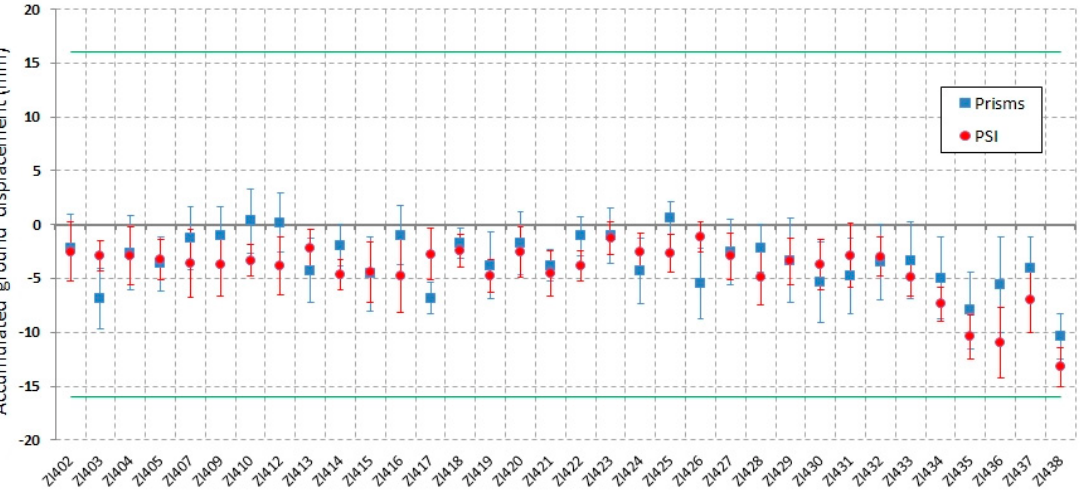
Figure 11. Accumulated displacements from 11 November 2015 to 15 May 2017 for prisms (robotic station) and corresponding PS (closed to the prisms positions) and its related standard deviations in the main Germano dam. The error bar limits (±16 mm) are shown in green